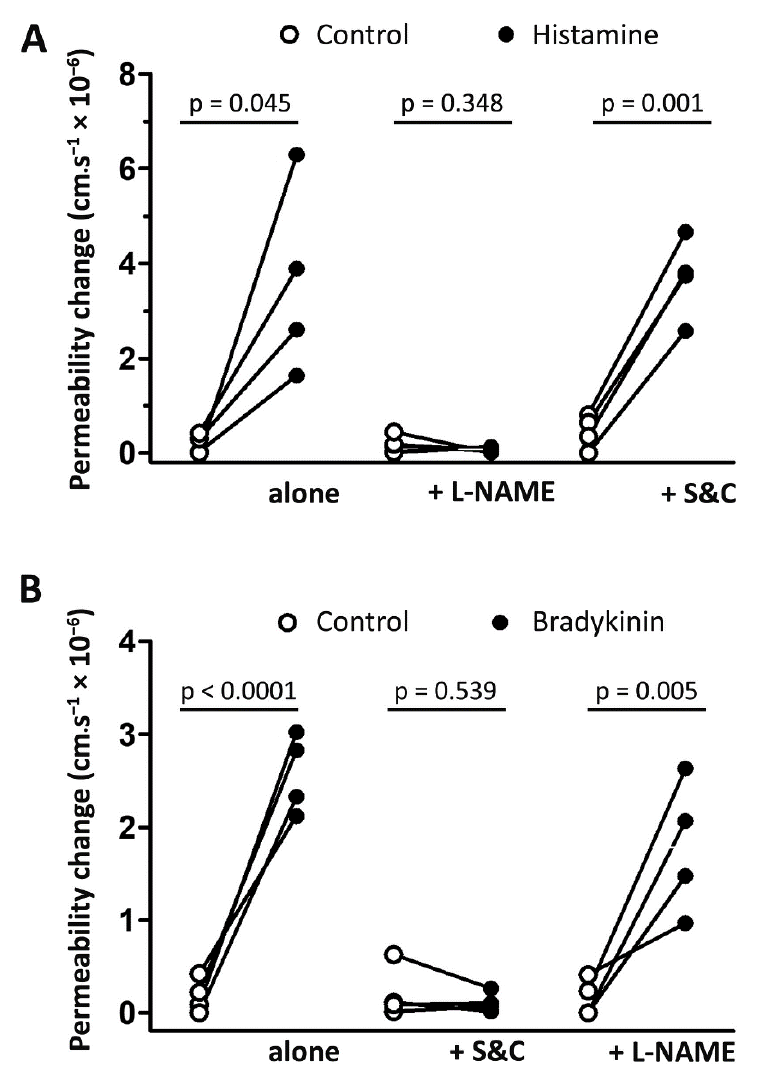
Figure 3. Involvement of reactive oxygen species and nitric oxide in histamine- and bradykinin-induced permeability. Changes in venular permeability following application of histamine ( A ) or bradykinin ( B ) at 1 µ M in the absence or presence of superoxide dismutase (SOD, 100 U · mL − 1 ) and catalase (CAT, 100 U · mL − 1 ) or L-NAME (10 µ M). Data from paired measurements in 4 venules from 4 di ff erent animals. Data were analyzed using a paired Student’s t -test.